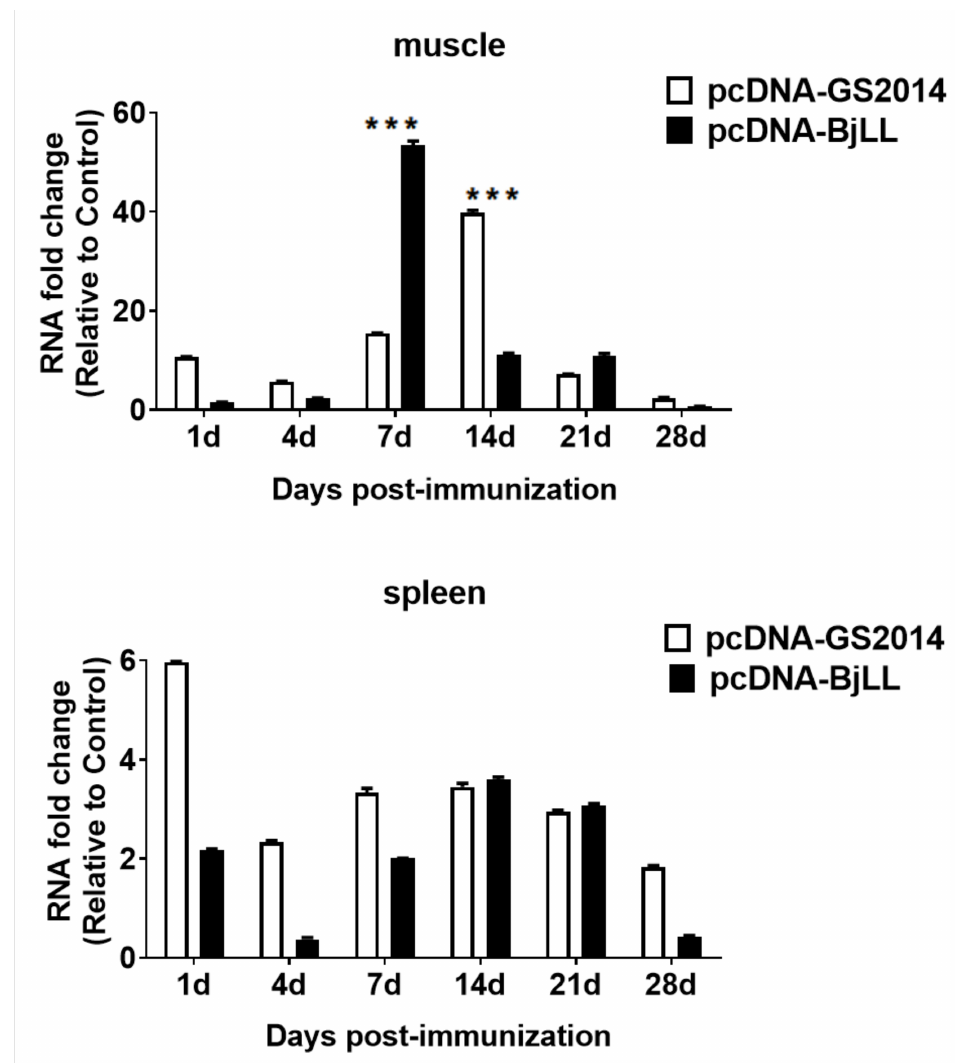
Figure 4. Relative expression of Mx1 gene postvaccination. The Mx1 gene expression in spleen and muscles of the injection site at days 1, 4, 7, 14, 21, and 28 after immunization were measured by RT-qPCR. The data of immunization group were compared with that of PBS control group. Graphs are shown from three independent replicates (*** p <